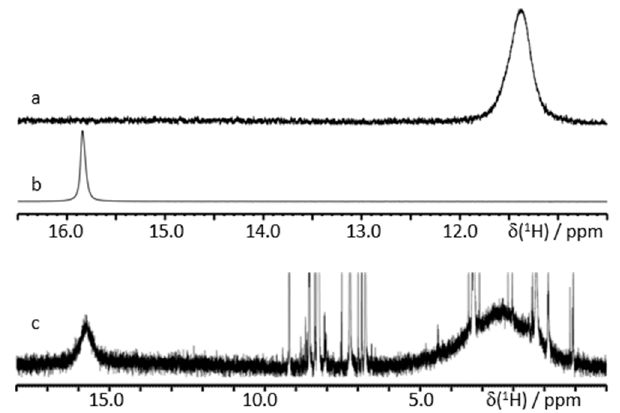
Characteristic 1 H NMR spectra of 4 in CDCl 3 at 300 K in the presence of DMAP. The mole fractions are ( a ) water: 4 :DMAP = 1:1.0:260, ( b ) water: 4 :DMAP = 1:3.9:260, and ( c ) water: 4 :DMAP = 1:0.24:0.30.